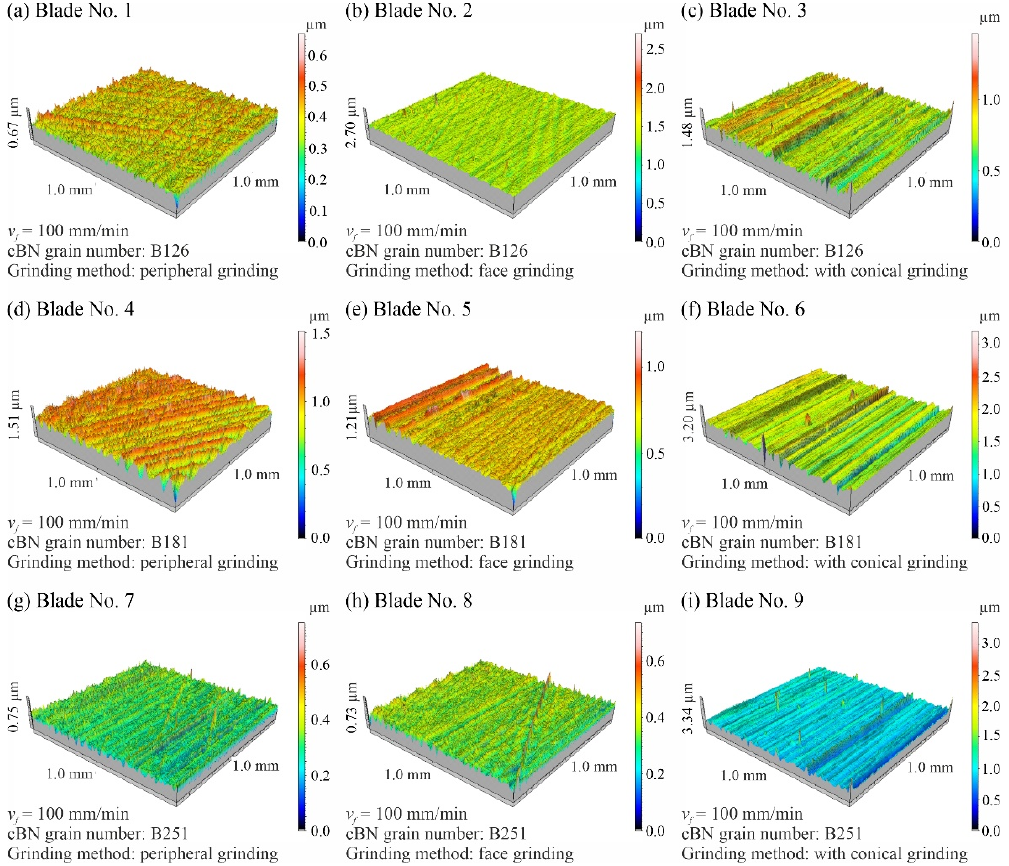
Figure 10. View of surfaces microtopographs (1.0 × 1.0 mm) recorded for nine selected planar blades on a measuring position equipped with a Hommel-Tester T8000 stylus profilometer from Hommelwerke GmbH (Villingen-Schwenningen, Germany): ( a ) blade no. 1; ( b ) blade no. 2; ( c ) blade no. 3; ( d ) blade no. 4; ( e ) blade no. 5; ( f ) blade no. 6; ( g ) blade no. 7; ( h ) blade no. 8; ( i ) blade no. 9.